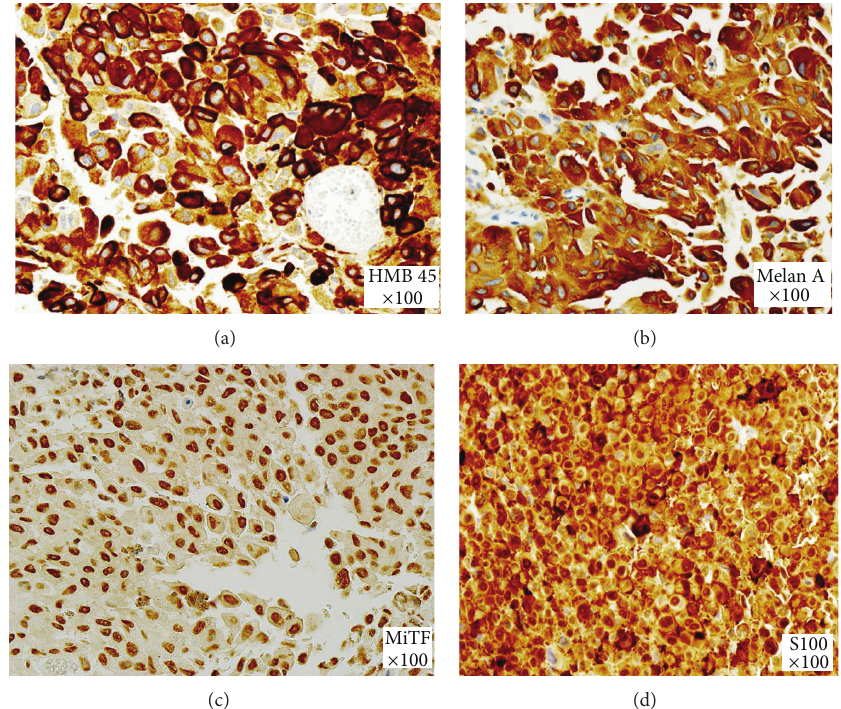
Figure 3: Marked cellular pleomorphism and numerous mitotic figures. Immunohistochemical examination showed S100(+), HMB45(+), MelanA(+), and MiTF(+).